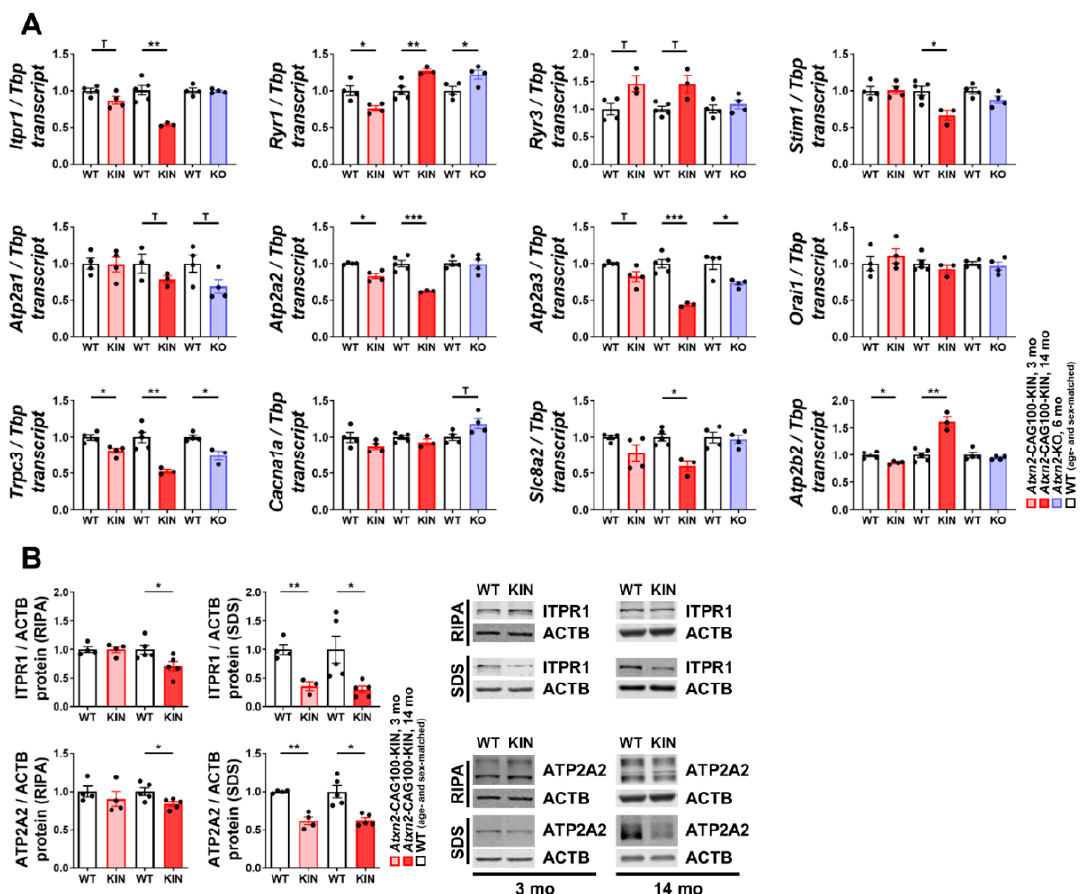
Figure 2. Expression analyses of Ca 2 + channels, transporters and associated factors in Atxn2 -CAG100-KIN cerebellum throughout the disease course. ( A ) Transcript levels of various plasma membrane and ER resident Ca 2 + -associated factors in Atxn2 -KO (blue bars) and Atxn2 -CAG100-KIN versus WT mouse cerebellum at pre-onset stage of 3 mo (pink bars) and terminal stage of 14 mo (red bars) were measured by RT-qPCR; ( B ) Protein levels of ER resident Ca 2 + channel ITPR1 and transporter ATP2A2 in soluble / cytosolic (RIPA) and insoluble / membrane-associated (SDS) protein fractions of Atxn2 -CAG100-KIN mouse cerebellum at pre-onset and final disease stages were determined by quantitative immunoblots. Student’s t -test with Welch’s correction; 0.05 < p < 0.1 T , p < 0.05 *, p < 0.01 **, p < 0.001 ***. Further information regarding individual fold changes and p -values can be found in Supplementary Table S3.